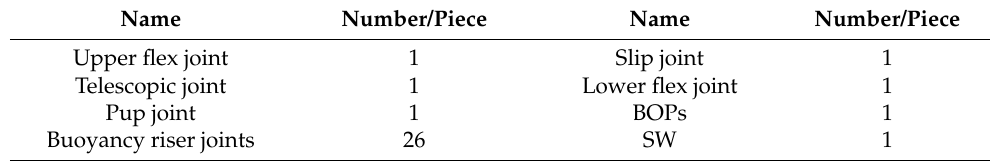
Table 2. Drilling riser configuration.